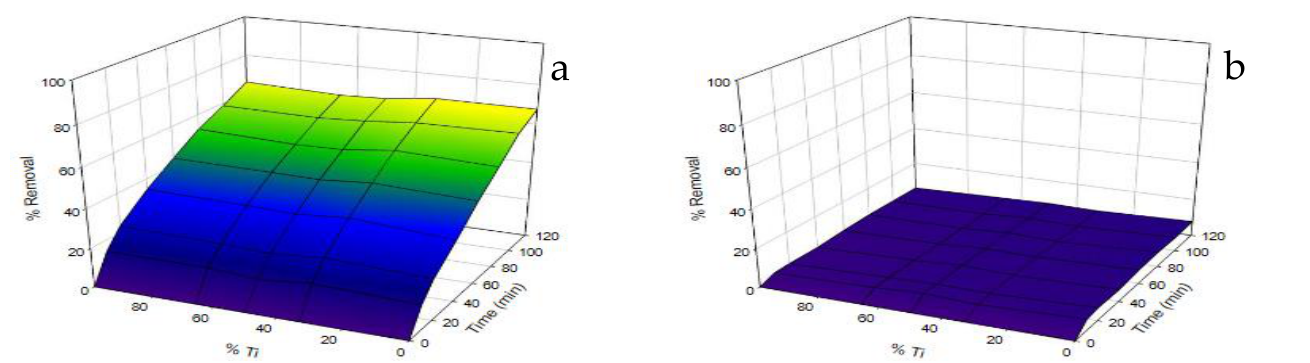
Figure 8. Three-dimensional curves of removal of 200 ppm ions with 10 ppm dye in the presence and absence of UV irradiation: ( a ) under UV irradiation; ( b ) without UV irradiation.